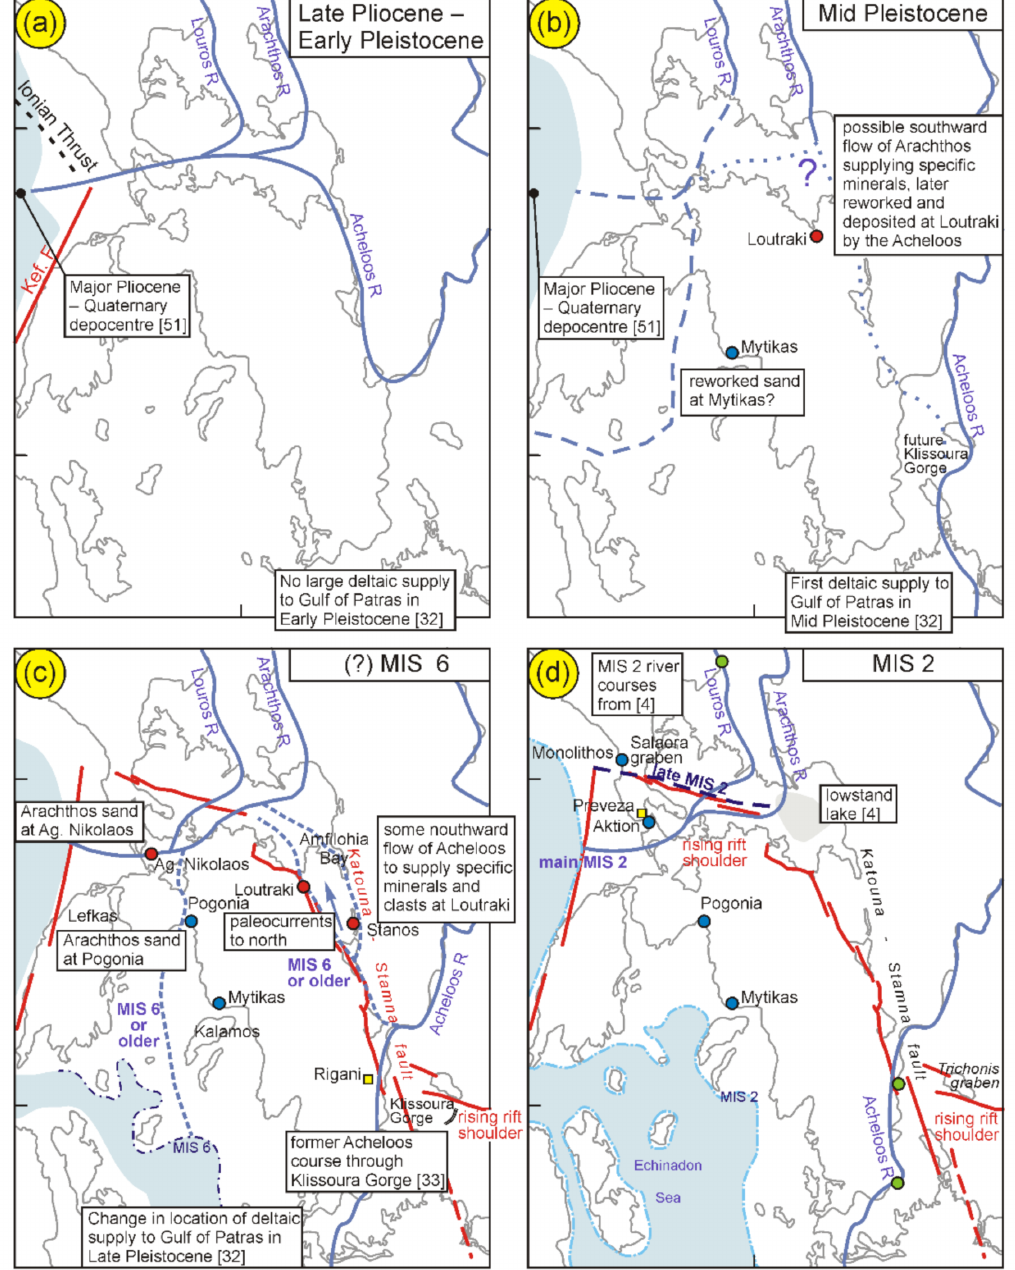
Figure 10. Maps showing inferred evolution of the drainage system through the Quaternary, based on our heavy mineral studies and supplementary information from [4,32,33,51]. Paleoshorelines in Echinadon Sea from [19], Katouna–Stamna fault zone from